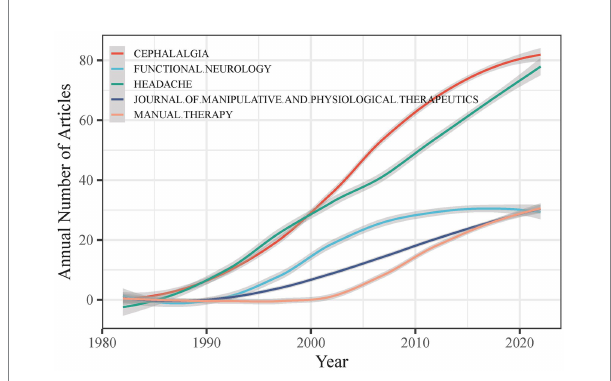
FIGURE 7 Temporal analysis of CEH-related study publication sources.